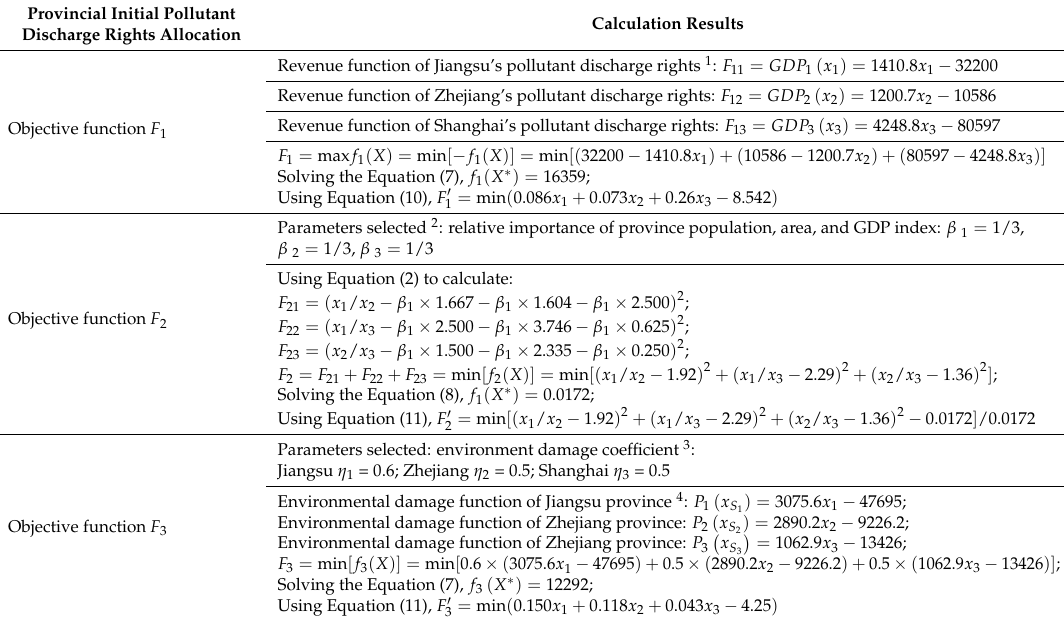
Table 2. Solutions of provincial initial pollutant discharge rights allocation (Taihu Basin, planning year